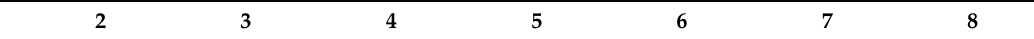
Table 1. Intercorrelations of stressors, health outcomes, and culture in Latinx